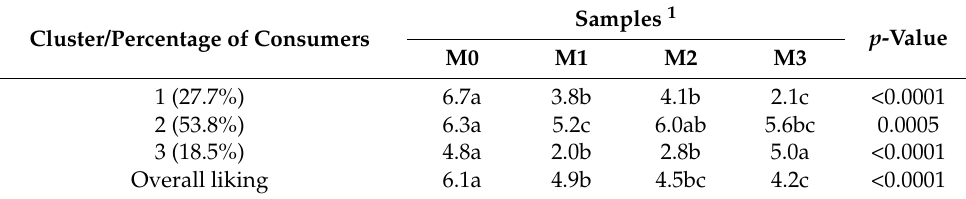
Table 9. Overall liking of the meat packages for the clusters of consumers obtained from agglomera- tive hierarchical clustering. Cluster/Percentage of